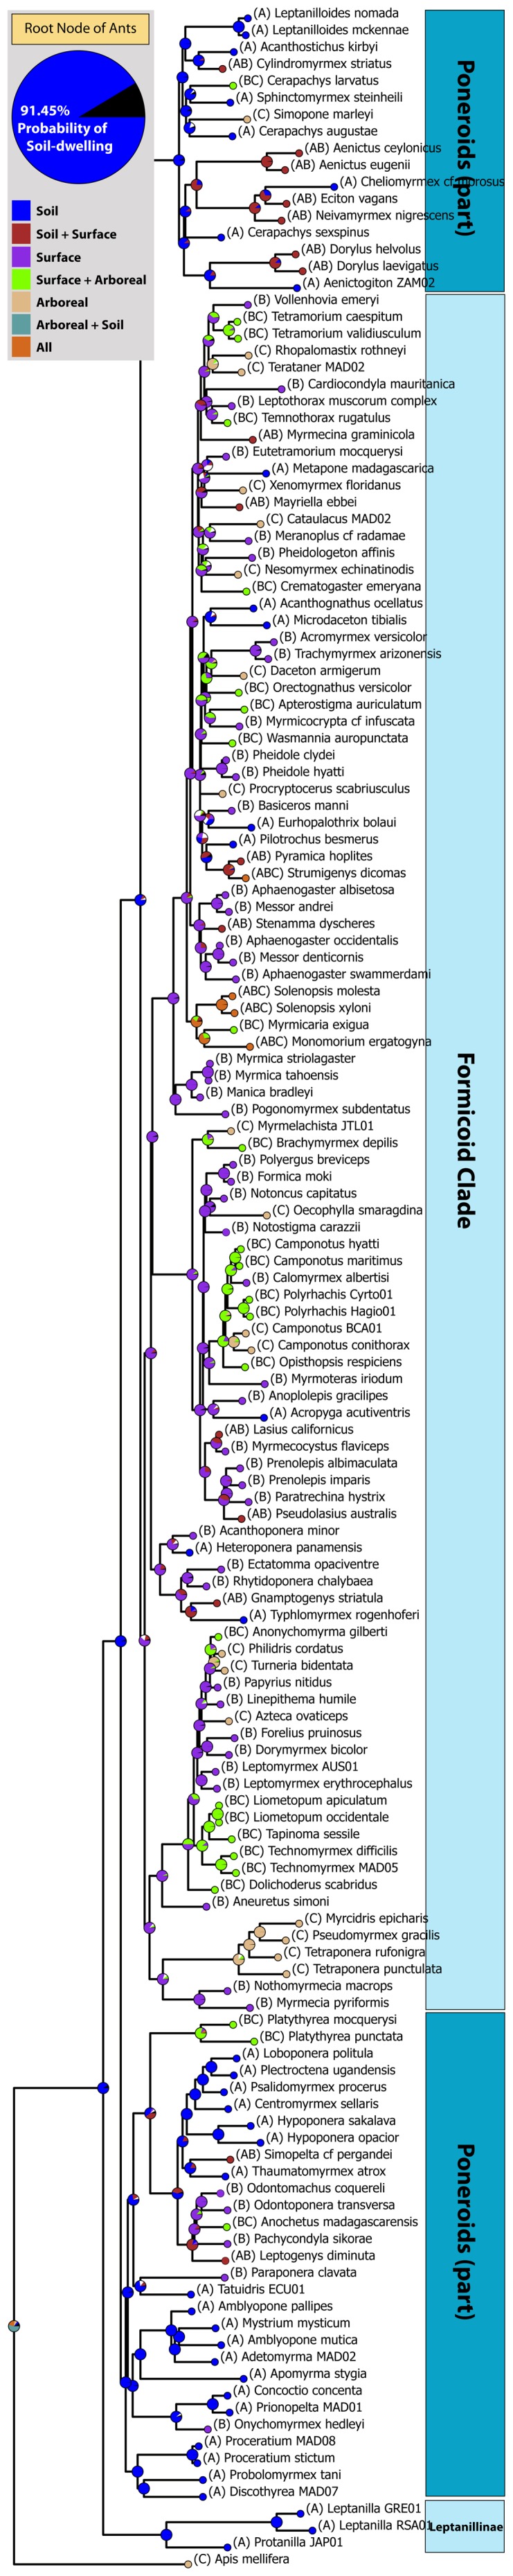
Ancestral state reconstruction of ant habitat.Ancestral state reconstruction of ant habitat strata based on phylogram plus 500 trees sampled from the original likelihood distribution of Brady et al. [9]. The outgroup in this reconstruction performed in the program RASP was coded as soil-dwelling, surface-dwelling or arboreal. The root node of ants is reconstructed as being subterranean (soil dwelling) with a posterior probability of 91.45%.